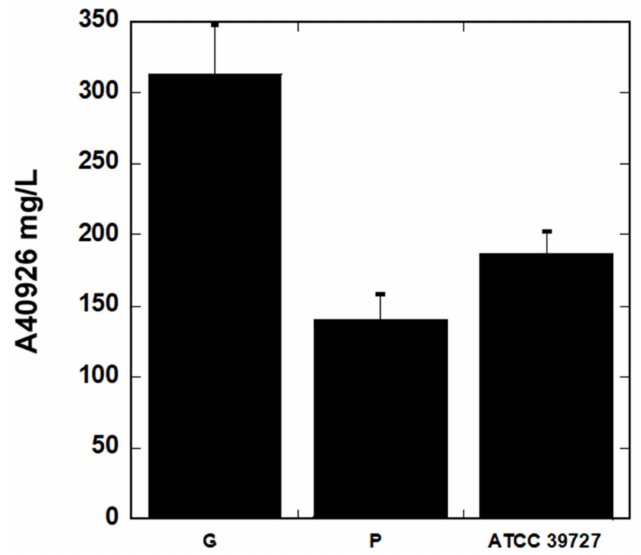
Figure 3. A40926 production, expressed in mg/L, of N. gerenzanensis ATCC 39727 and of its G and P variants grown in FM2 for 144 h after the inoculum in 500 mL Erlenmeyer flasks. Results given are the mean values from the cultivation and extraction of ten independent colonies per each condition. Bars indicate ± 1 standard deviation.